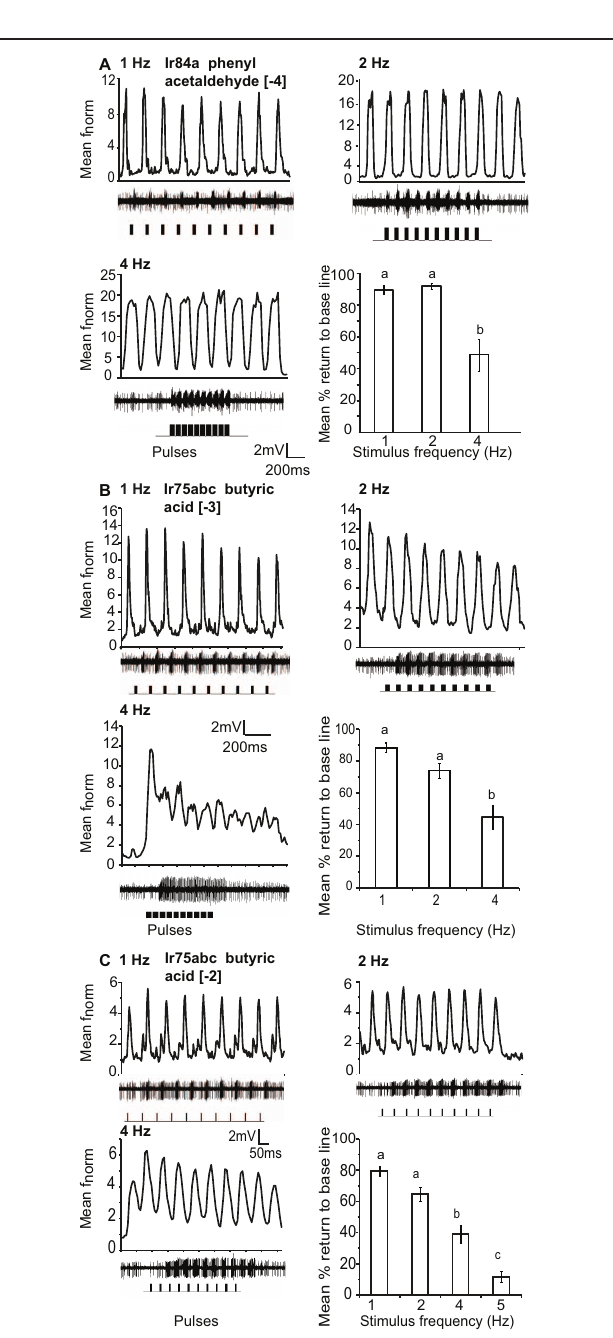
FIGURE 4 | Response of OSNs to repeated stimulus pulses at varying frequencies. (A) Average normalized PSTH responses for Ir84a-expressing neurons in response to repeated pulses of log [ − 4] v/v phenyl acetaldehyde at listed frequencies. Traces below each panel show sample 200ms recordings. Square pulses indicate stimulus presentation. The final panel shows the mean percent return to base line across all pulses at listed frequencies; error bars indicate SEM (ANOVA, P < 0 . 05, followed by Tukey post-hoc , n = 7–9). (B) Response of Ir75abc-expressing neurons to repeated stimulations of log [ − 3] v/v butyric acid stimulation as in (A) (ANOVA, P < 0 . 05, followed by Tukey post-hoc ( n = 8–10). (C) Response as in (B) to a 10 × concentration of butyric acid (log [ − 2]); ANOVA, P < 0 . 05, followed by Tukey post-hoc , n = 14–15).